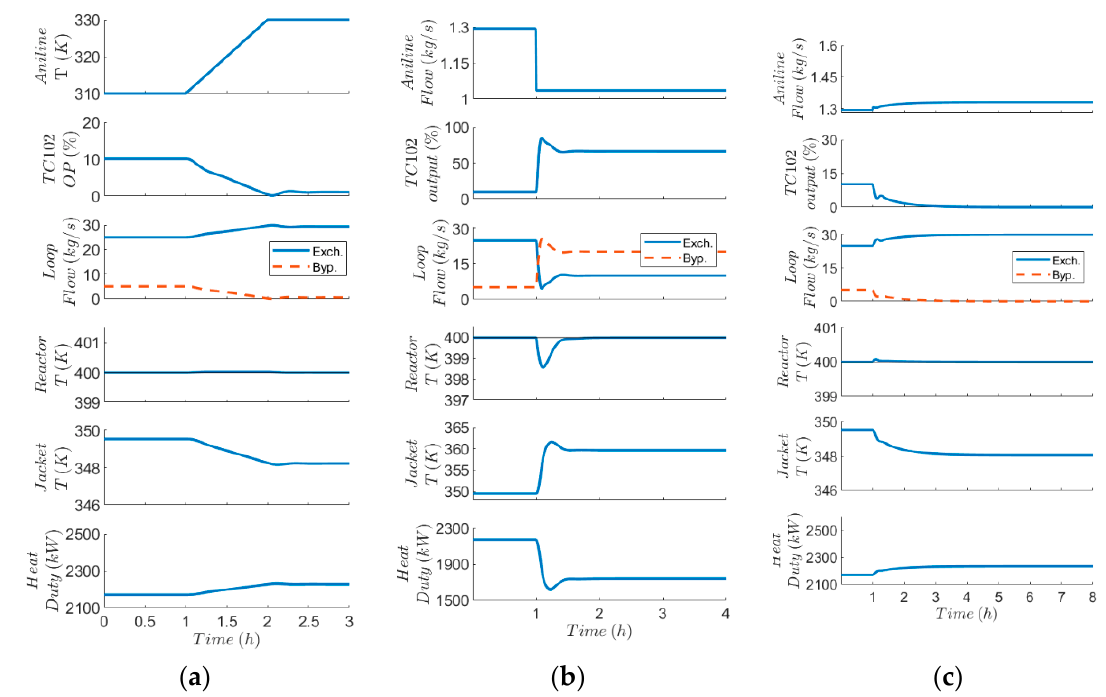
Figure 12. Control performance of plant Design D2 under ( a ) Scenario 1, ( b ) Scenario 2, and ( c ) Scenario 3.